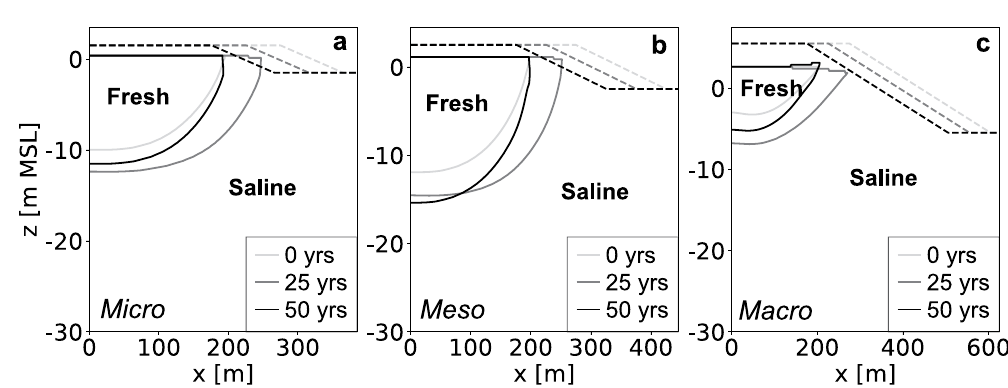
Figure 9. Simulated growth of the fresh groundwater lens for micro (left), meso (centre), and macro (right) tidal ranges. All images show the fresh-salt groundwater interface of 1 g TDS L − 1s (solid lines) and the surface elevation (dashed lines) at the start (light grey), middle (dark grey) and end (black) of the simulation